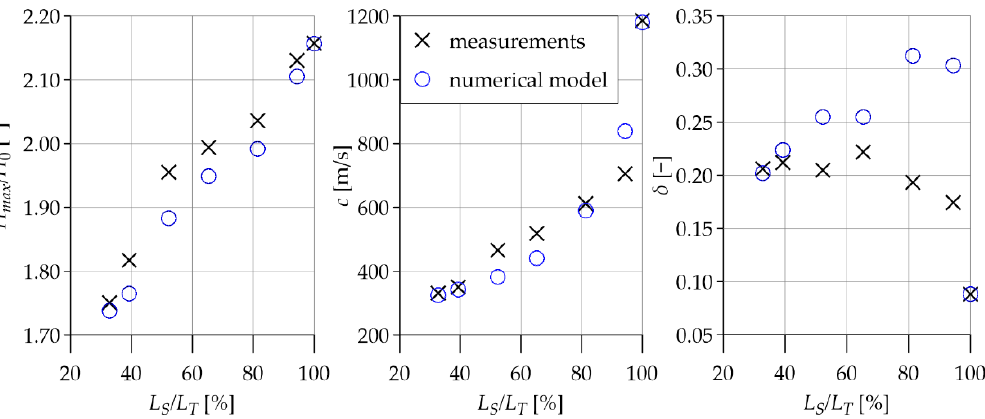
Figure 11. Comparison between calculated and measured values of the dimensionless pressure increase, mean pressure wave velocity, and the logarithmic damping decrement.